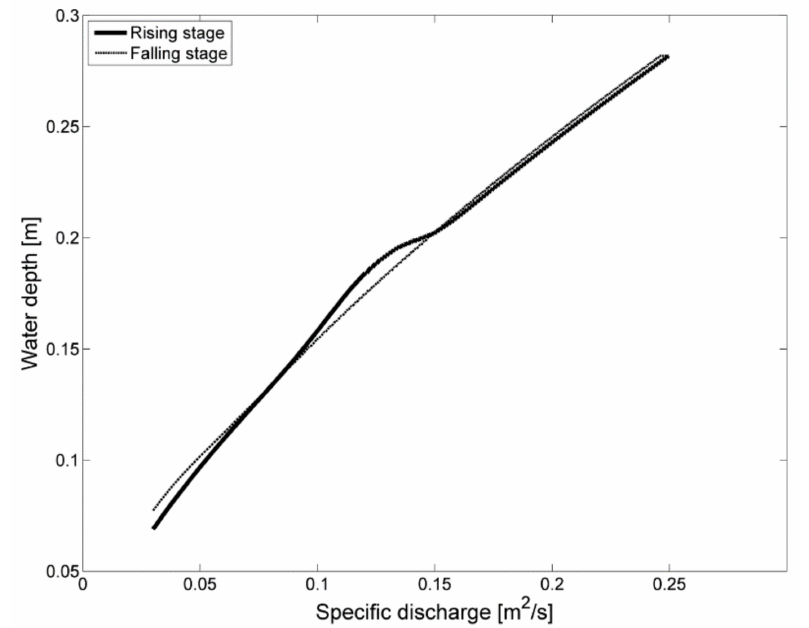
Figure 9. Specific discharge versus water depth separated for the rising and falling stages of the hydrograph, using scenario A4 from Shimizu et al.